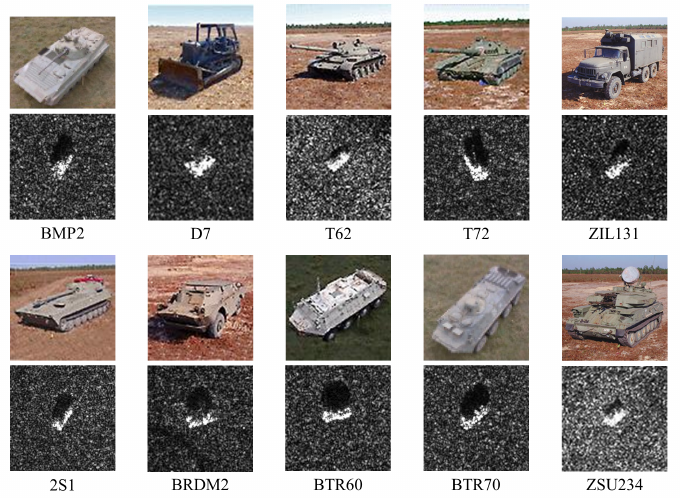
Figure 6. Optical images ( top ) and SAR images ( bottom ) for the ten targets in the MSTAR dataset. Table 1. The detailed dataset settings in our experiments. Two test sets were set up to evaluate the performance under different classes and depression